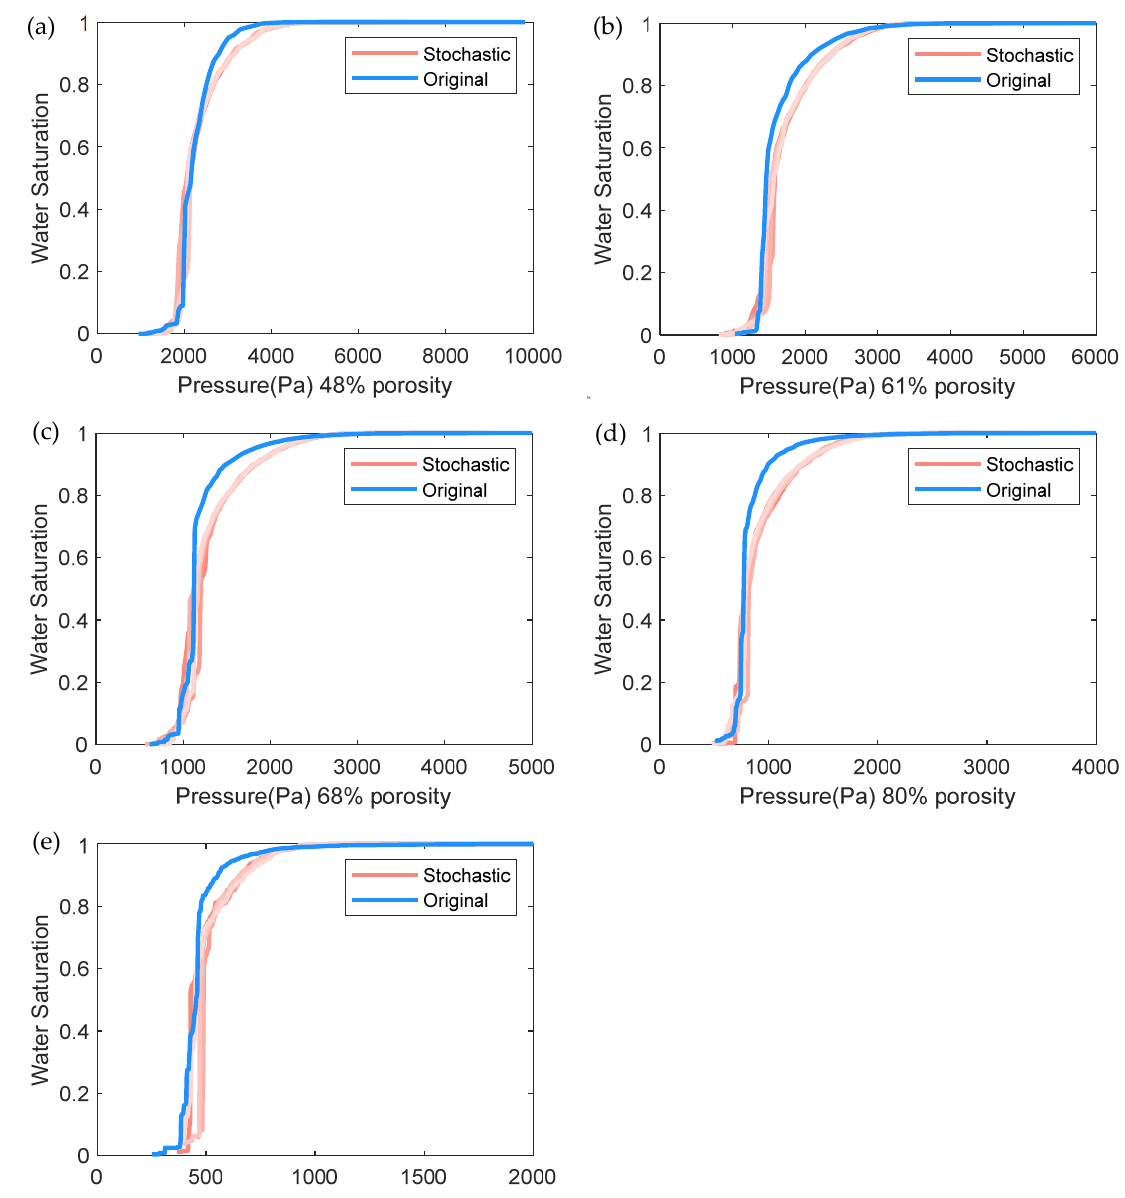
Figure 10. Capillary pressure curves of the original and stochastic pore network. Five stochastic realizations are generated for each porosity ( a ) 48%, ( b ) 61%, ( c ) 68%, ( d ) 80%, and ( e )